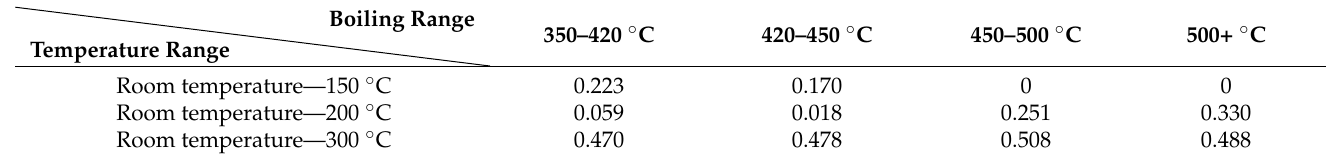
Table 5. R COx/O2 of pseudo-components at different temperature ranges.